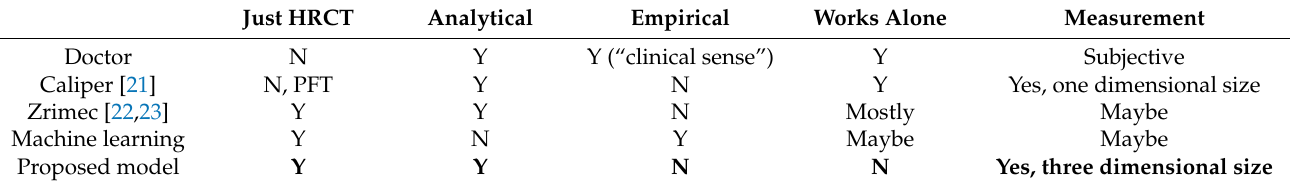
Table 3. Methodology